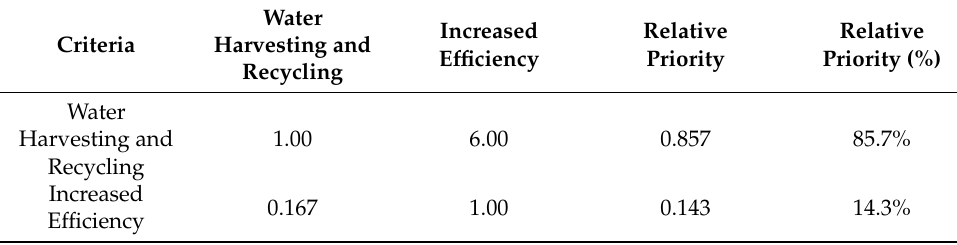
Table 8. Paired comparison matrix for the water efficiency (WE) attribute in